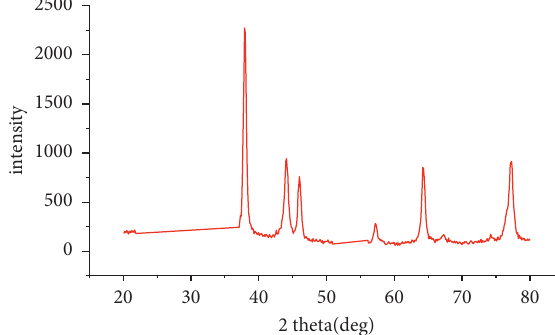
Figure 3: X-ray diffraction (XRD) patterns of